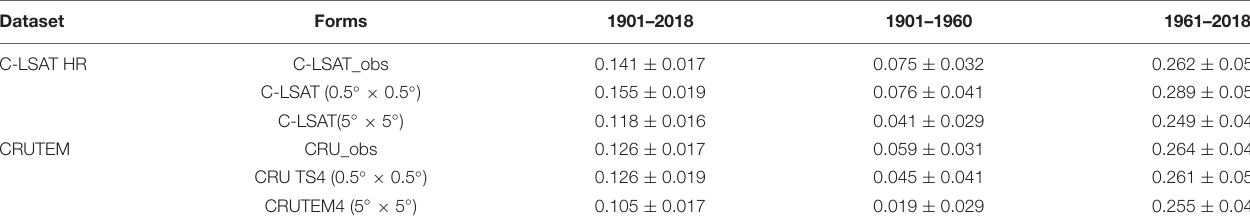
TABLE 3 | Warming trends ( ◦ C 10a − 1 ) and their uncertainty at 95% confidence level of annual LSAT anomaly from observation and gridded datasets over Pan-East Asian. Dataset